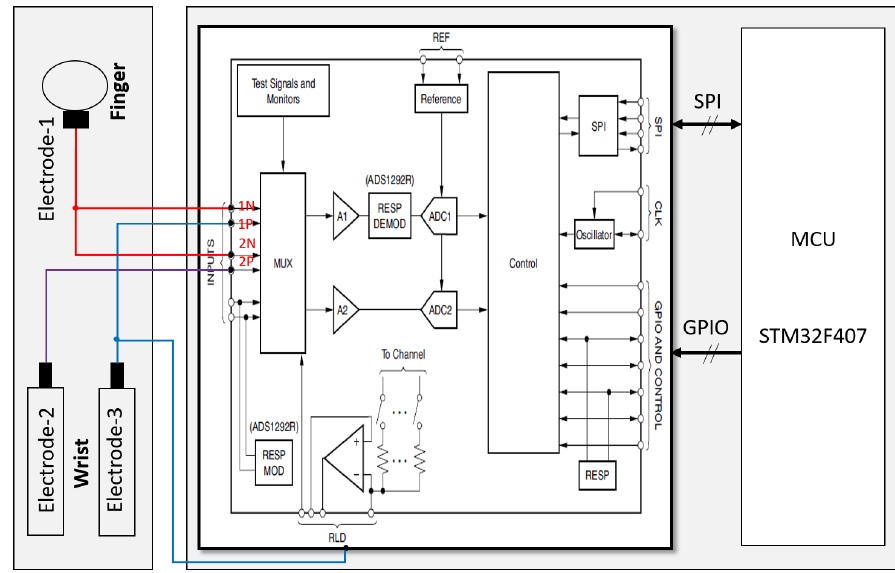
Figure 4. A block diagram of ECG signal processing module.